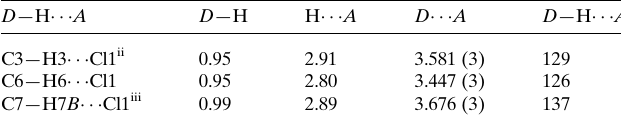
Table 3 Hydrogen-bond geometry (A˚ , (cid:4) ) for I .